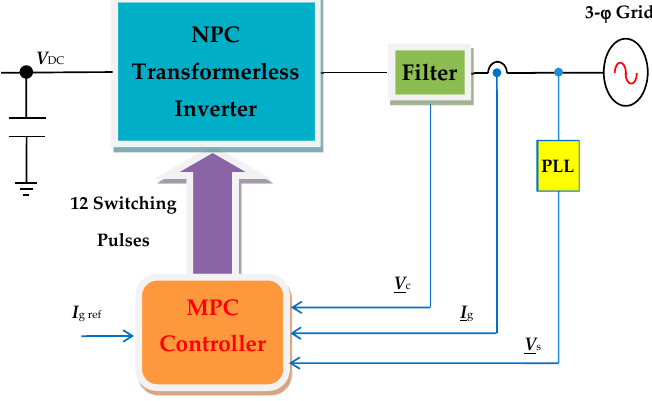
Figure 6. Model predictive control (MPC) block diagram.